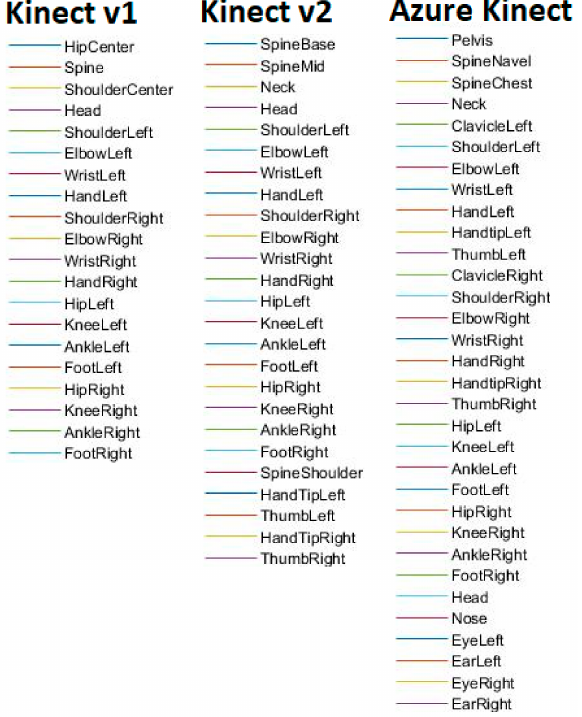
Figure 7. List of skeleton body joints detected by corresponding Kinect sensor (the presented colors are used in all figures throughout the